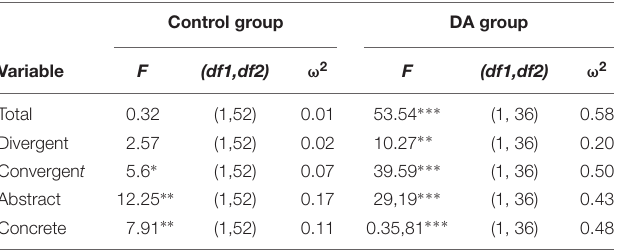
TABLE 5 | Main within subject effect of time by group.